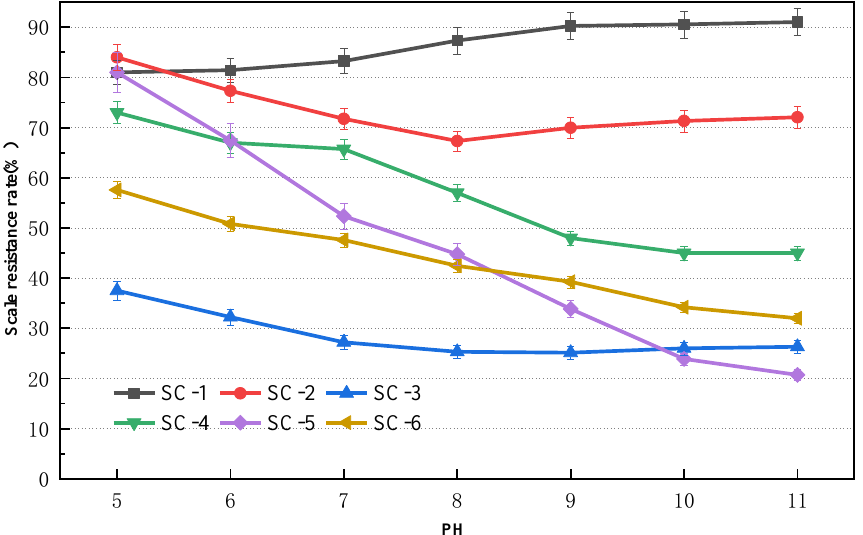
Figure 4. Effect of scale inhibitor on calcium sulfate at different pH levels and room temperature.